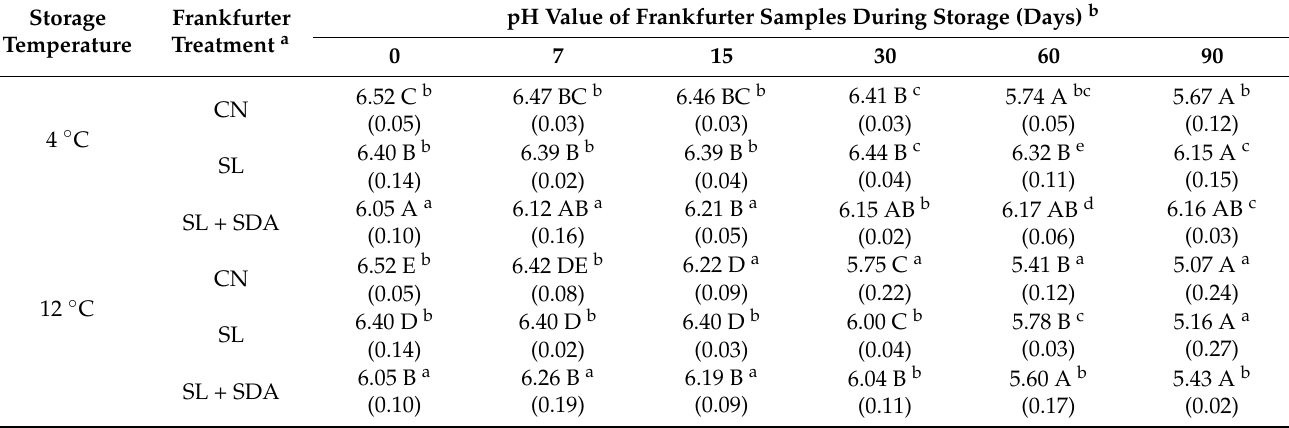
Table 1. Changes in pH of vacuum-packaged frankfurters during storage at 4 ◦ C and 12 ◦